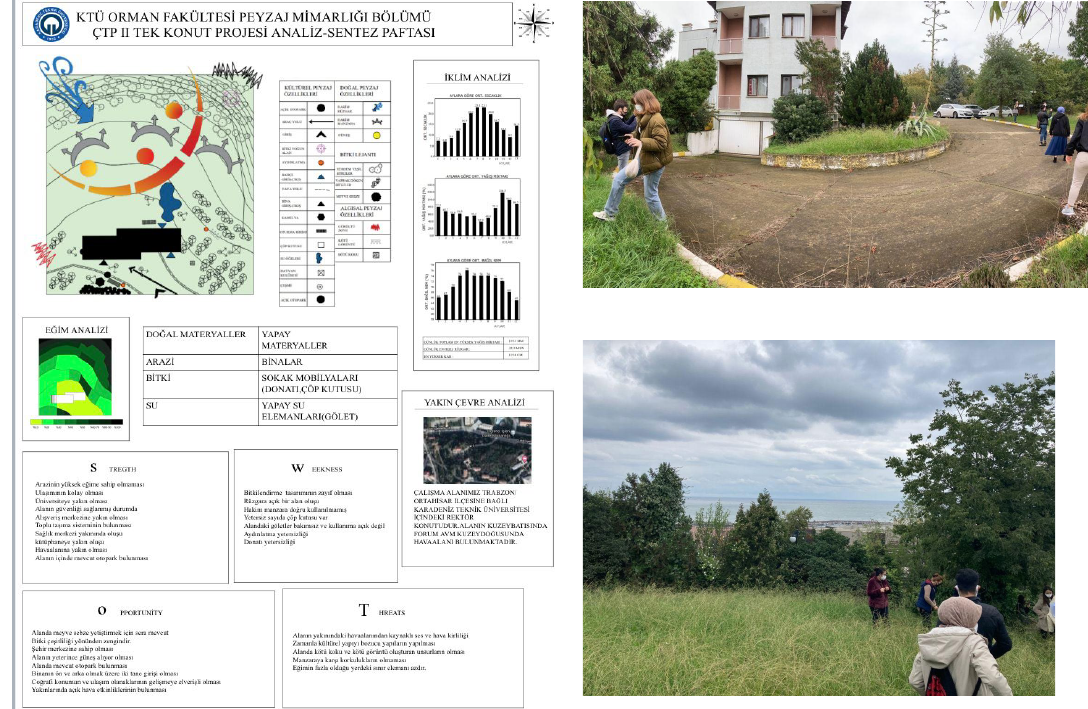
Figure 2 Survey posters and photos from the field